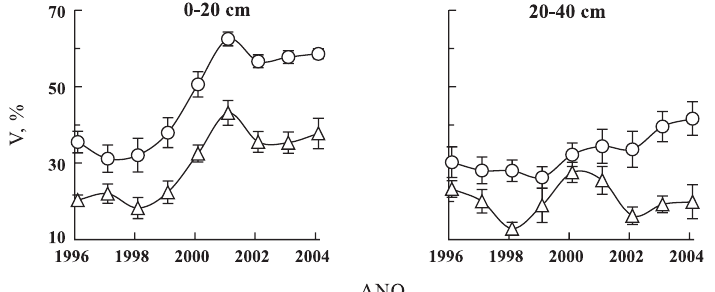
Figura 3. Valores médios e intervalos de confiança da média (p < 0,05) pelo teste t (barras verticais) da saturação por bases (V), antes (1996) e após as calagens superficiais (1997-1999), nas faixas de adubação ( ) e no centro das entrelinhas ( ) a 0–20 e 20–40 cm de